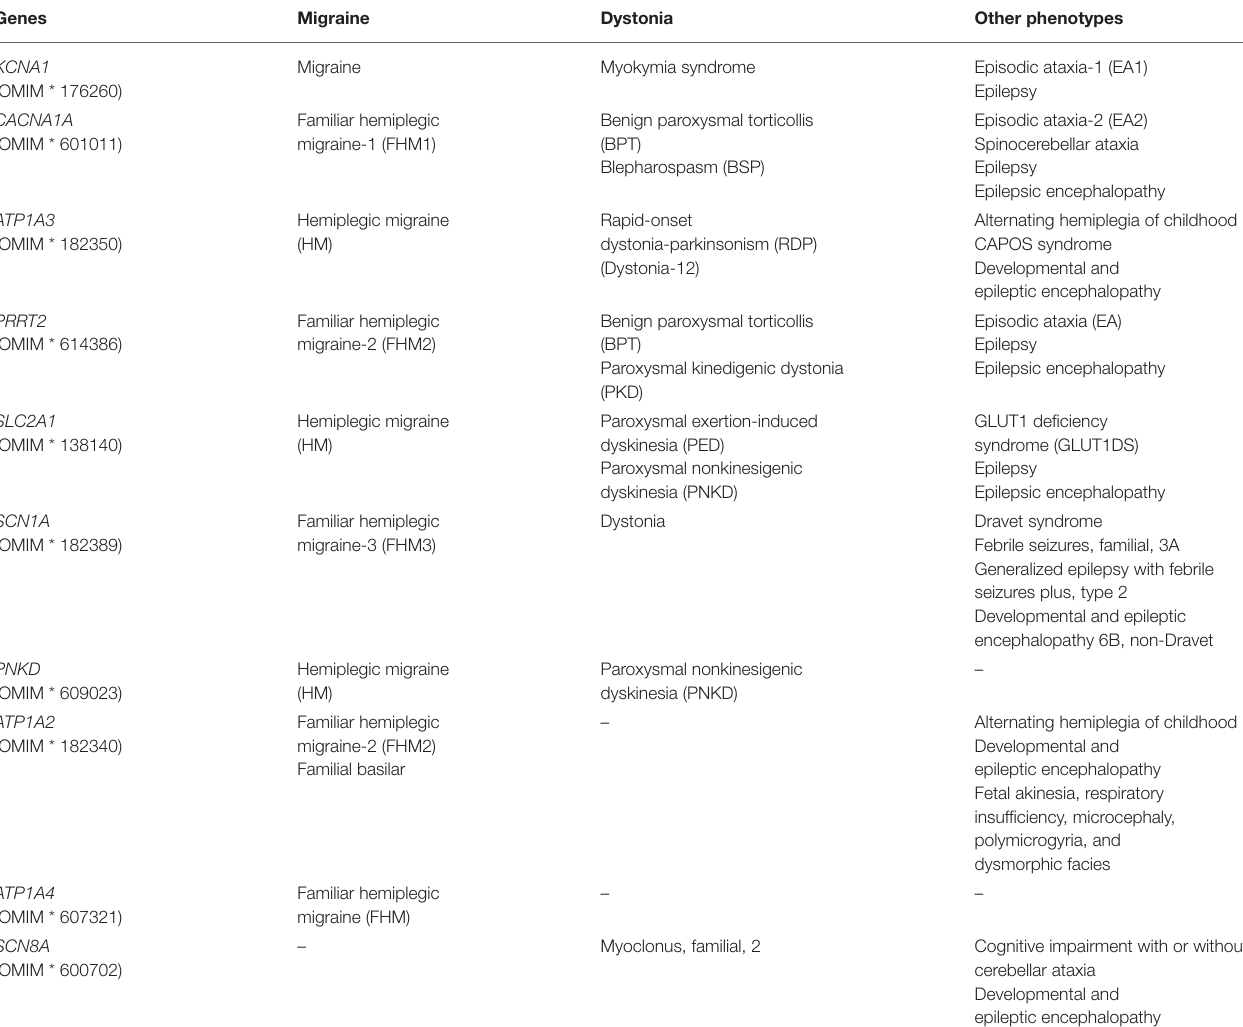
TABLE 1 | Main phenotypic pleiotropy in genes associated with migraine and dystonia.